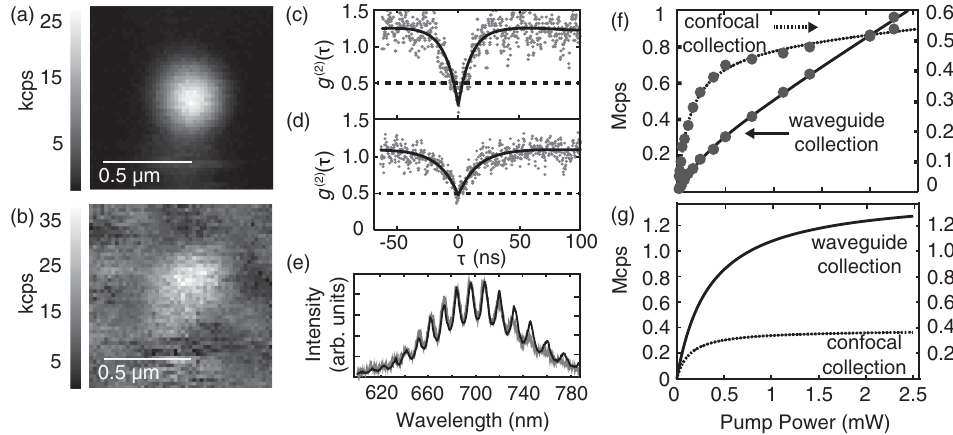
FIG. 3. (a) High-resolution confocal PL raster scan of the NV with confocal collection and (b) waveguide collection. For (b), the background is subtracted using spin-selective fluorescence [32,33]. (c) Normalized autocorrelation measurement g ð 2 Þ ð τ Þ via confocal collection confirming single photon emission. (d) Cross-correlation measurement between photons collected via the confocal setup and through the waveguide confirming that the majority of photons collected through the waveguide originate from a single NV. Solid curves in (c) and (d) are fits to the data. (e) Spectrum of the emitter collected via the waveguide. The solid curve is a model with parameter values taken from measured data as detailed in Appendix E. (f) Saturation measurements acquired on the same emitter with confocal (dashed line) and waveguide (solid line) collection. (g) Fits from (f) without background and corrected for measured collection losses (see